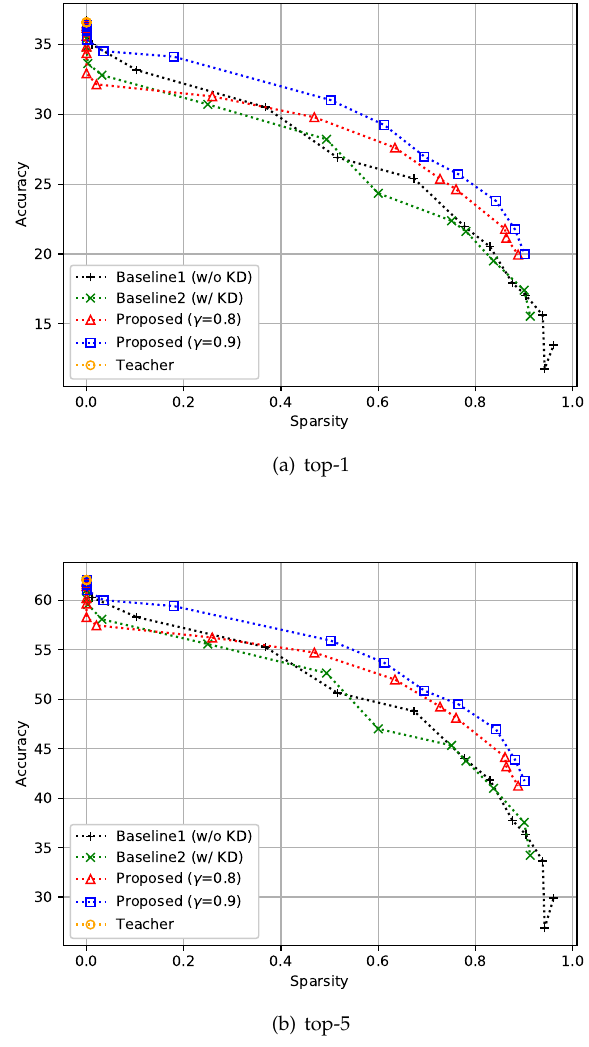
Figure 7. Effect of the proposed strategies on ImageNet32 × 32. Here, the hyper-parameter γ is the relaxation variable shown in Equation